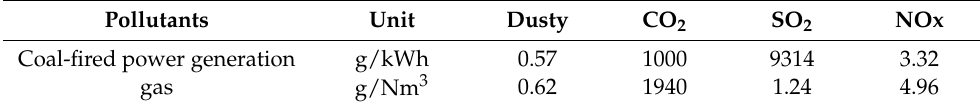
Table A10. Pollutant emission